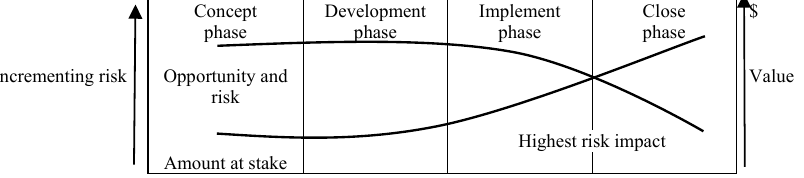
Fig. 1. Correlations Between the Level of Risks Associated with A Project and the Amount at